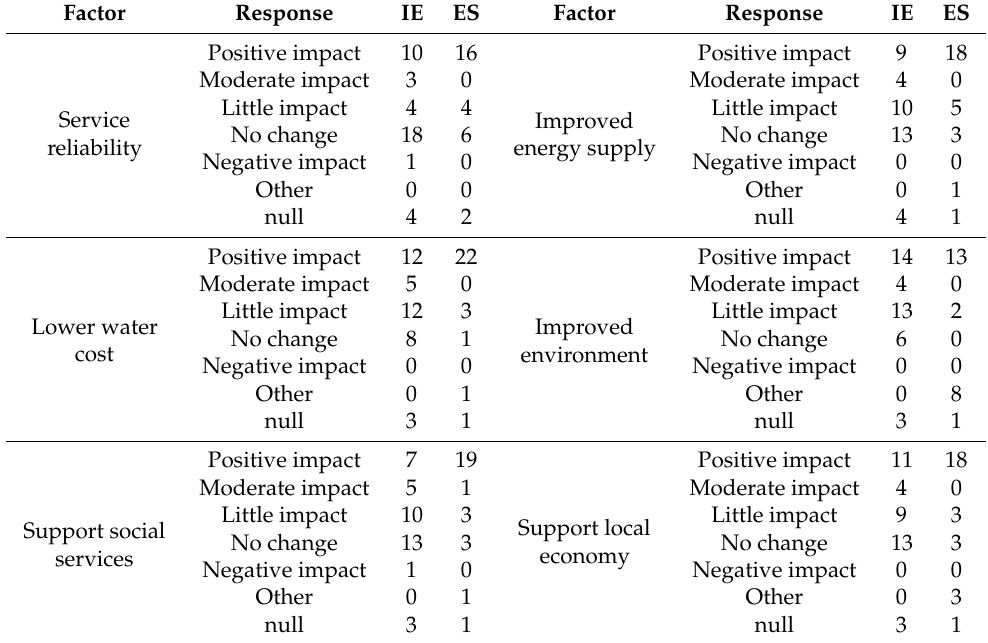
Table 2. Perceived impact of MHP systems in water networks.